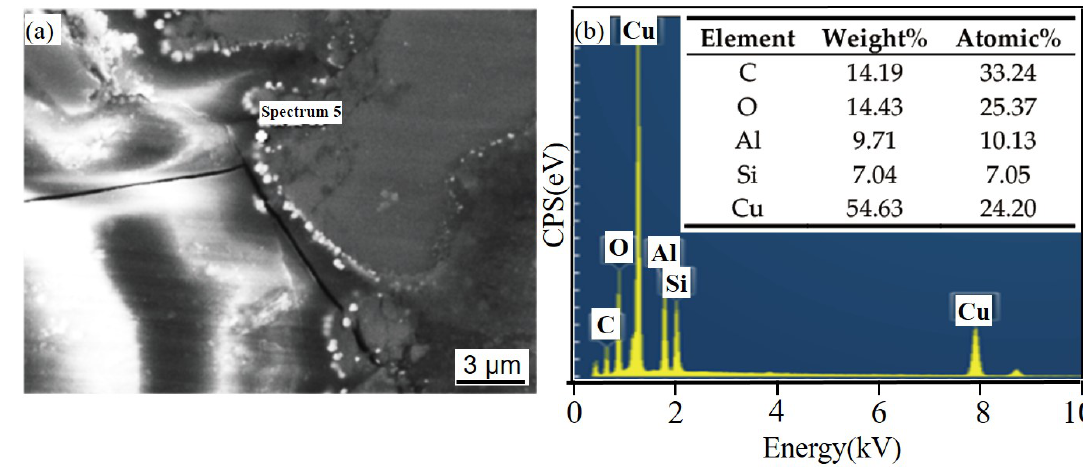
Figure 16. EDS of matrix cracks in SiC 3D /6061Al after SL for 61 days. ( a ) SEM image of matrix cracks; ( b ) EDS of matrix cracks.